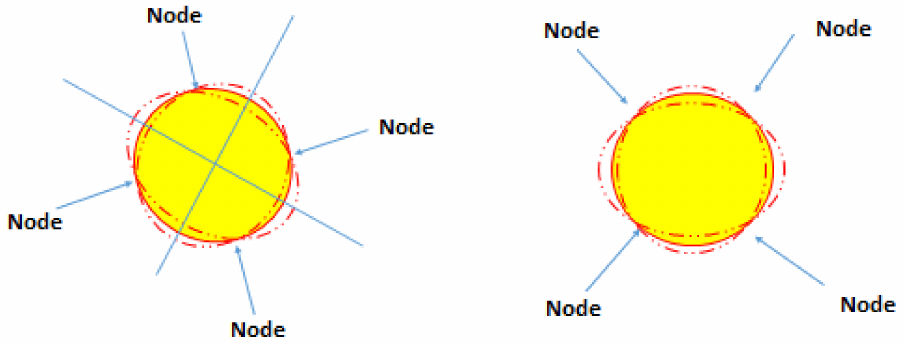
Figure 4. Two possible vibrating modes of an HRG (two standing wave